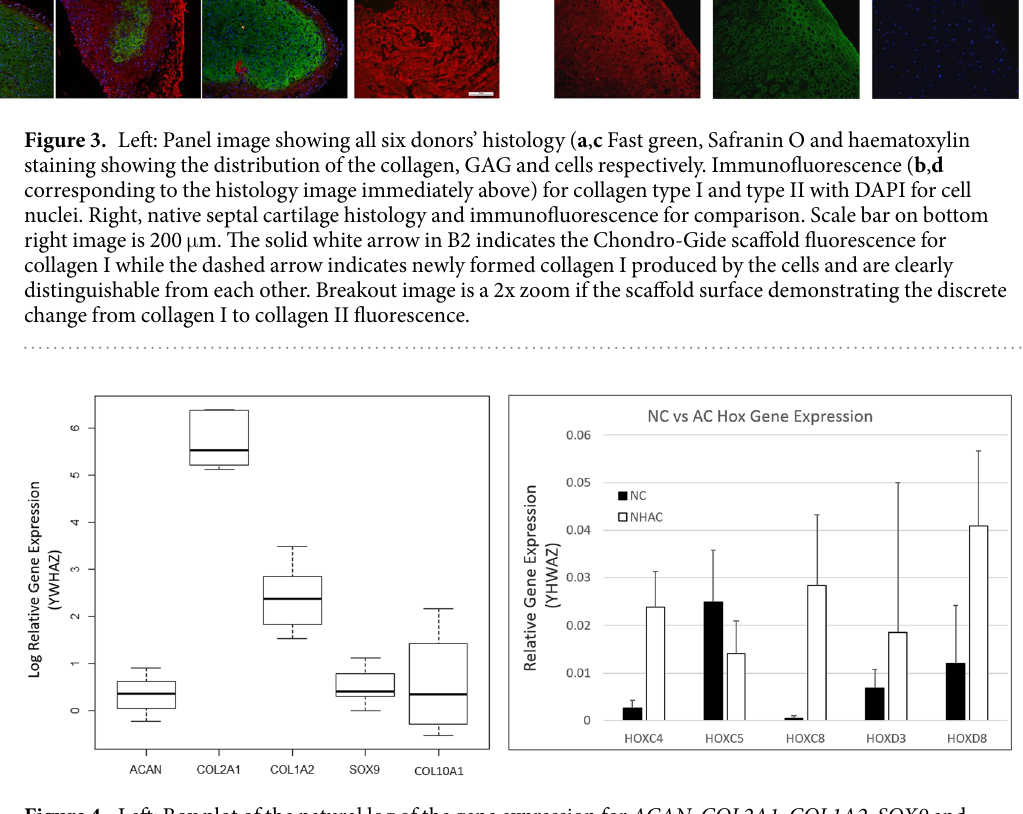
Figure 4. Left: Box plot of the natural log of the gene expression for ACAN , COL2A1 , COL1A2 , SOX9 and COL10A1 from objective 1. Gene expression showed a lognormal distribution with Shapiro Wilk p > 0.05 and non-skew boxplots. Relative gene expression of the Hox genes HOXC4 , HOXC5 , HOXC8 , HOXD3 and HOXD8 against the reference gene YHWAZ for nasal chondrocytes (NC) vs normal human articular cartilage (NHAC). Error bars ±